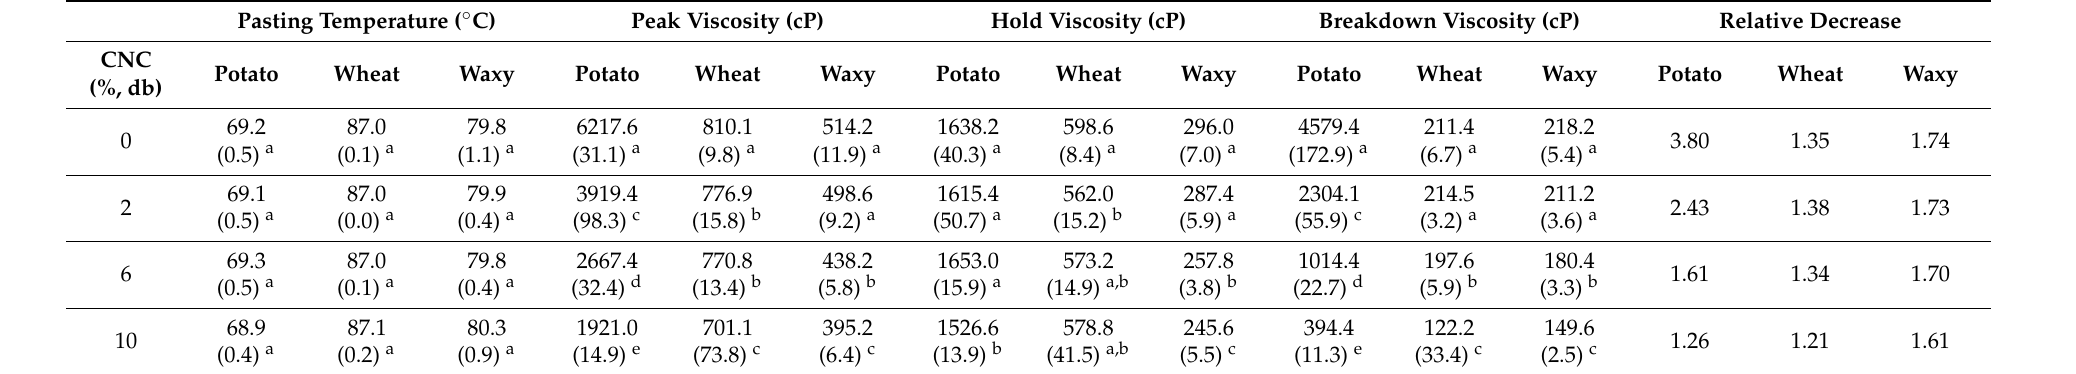
Table 1. Pasting properties recorded during the gelatinization of starch (potato, wheat and waxy corn) assessed by RVA in starch–CNC blends. Values in brackets correspond to standard deviation. Different upper letters in the same column represent significant differences ( p -value < 0.05). The relative decrease was defined as the ratio of peak viscosity over hold viscosity in starch samples containing the same amount of